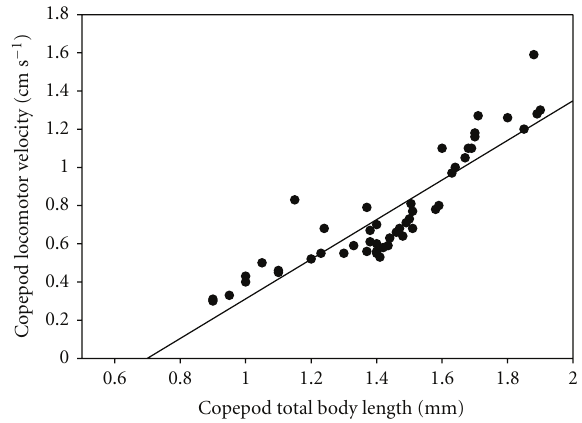
Figure 5: Relation of size versus escape speed in copepods (com- bined data from Calanus and Acartia ) in response to approaching baleen in still tank in light (in water at 20 degrees